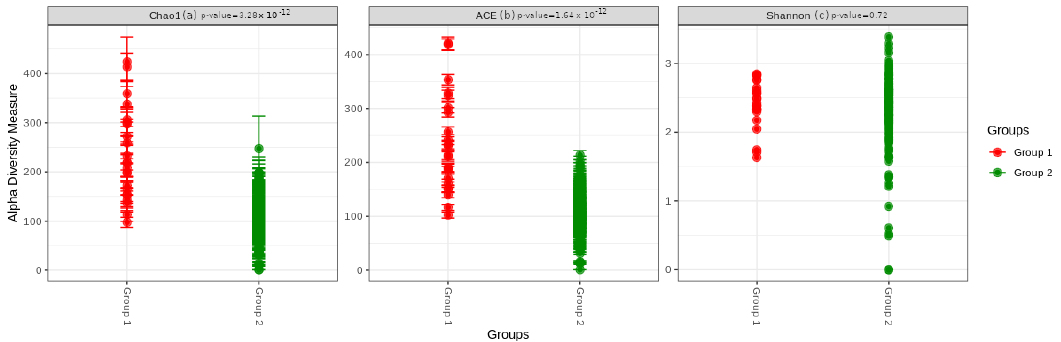
Figure 1. Alpha diversity indices boxplot between group 1 (BC survivors) and group 2 (healthy controls). Comparison based on the ( a ) Chao, ( b ) ACE, and ( c ) Shannon indexes.